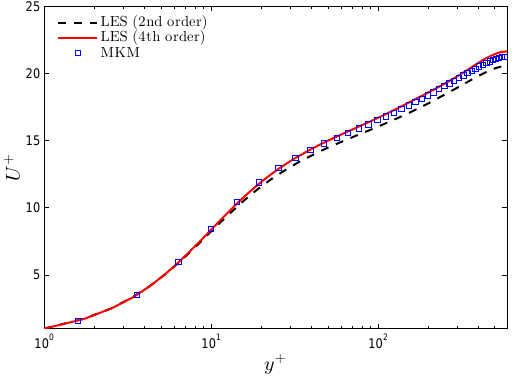
Figure 11. Mean streamwise velocity of turbulent channel flow by LES at Re τ = 590.